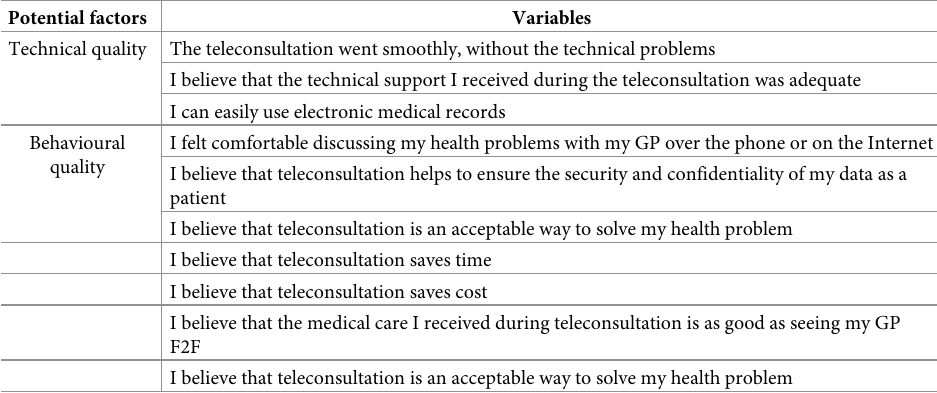
Table 2. Variables used to measure the system